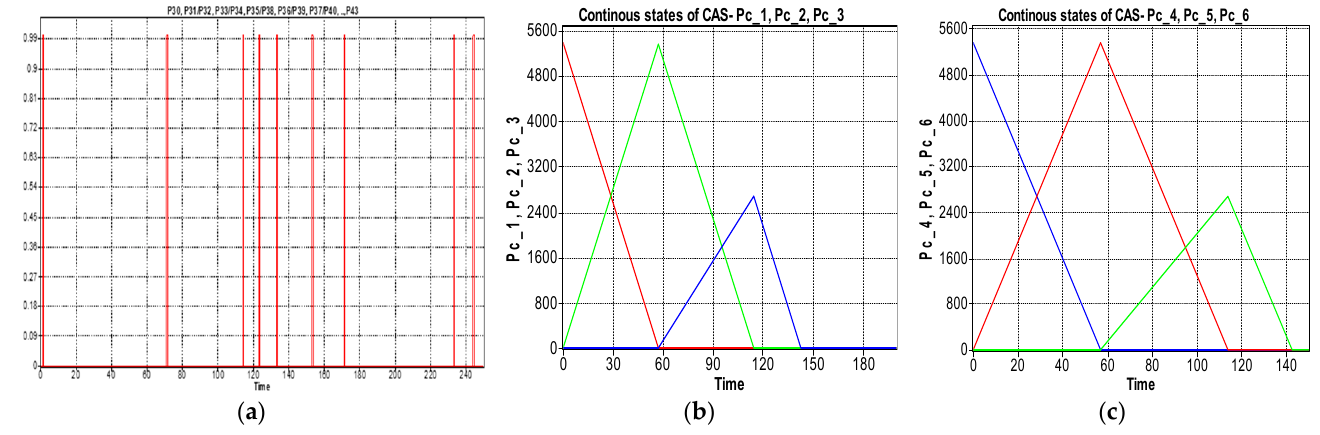
Figure 15. ( a ) The monitoring signals for the successive actions of the WP2 repair. ( b ) The continuous places evolution of the CAS (PeopleBot WMR), places: P c_1 ,P c_2 ,P c_3 for replacing cylinder 1. ( c ) The continuous places evolution of the CAS, places: P c_4 ,P c_5 ,P c_6 for replacing cylinder